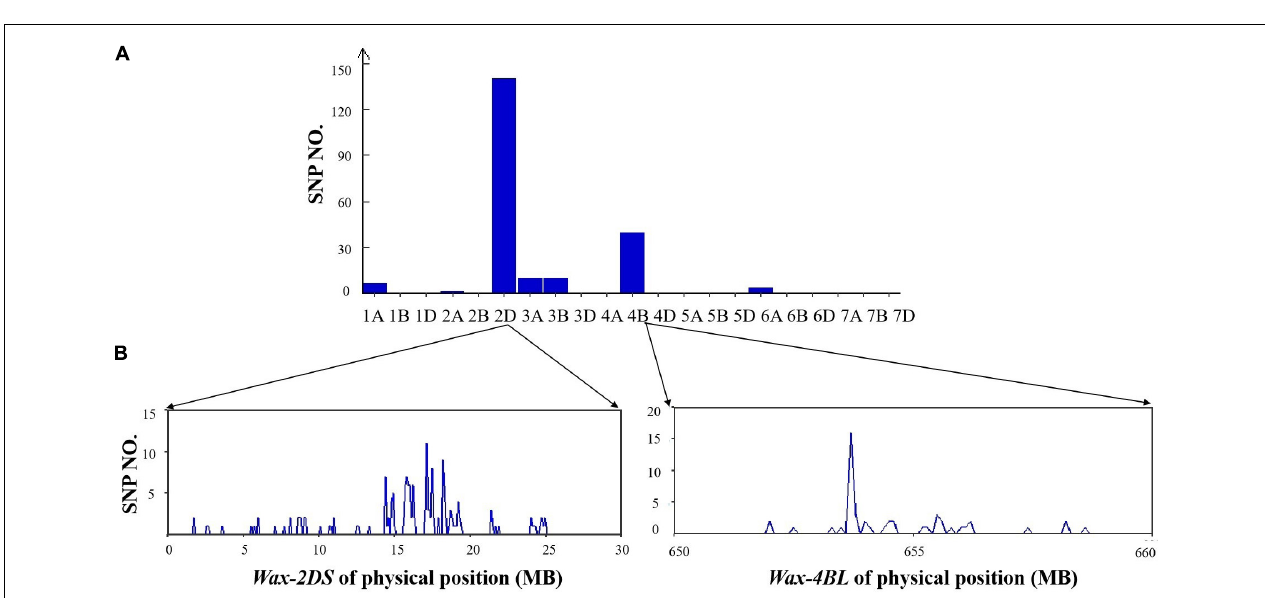
FIGURE 6 | (A) Distribution of polymorphic SNPs in each chromosome identified by the 660K SNP array. (B) Physical position of SNPs in chromosome 2D and 4B based on 660K SNP physical